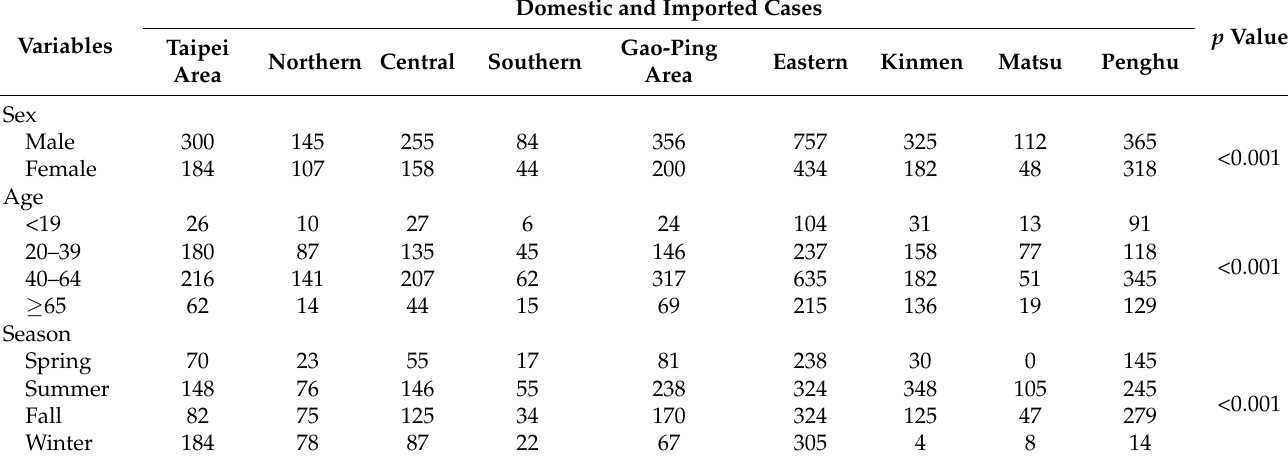
Table 4. Association between region of residence and gender, age and season from a survey of domestic and imported cases of scrub typhus between 2010 and 2019 in